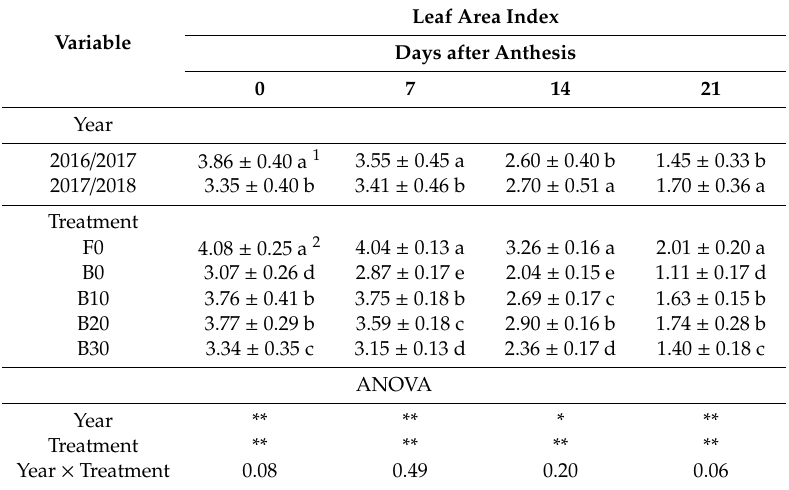
Table 5. Main e ff ects of year and treatment on leaf area index at 0, 7, 14, 21 days after anthesis.